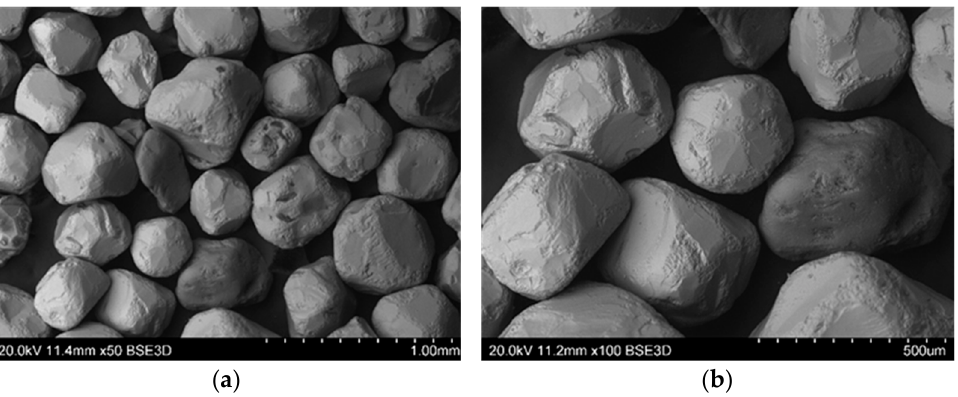
Figure 16. BSD images from the scanning electron microscope of the used sand on the R100 chromite matrix: ( a ) mag. 50×, ( b ) mag. 100×.